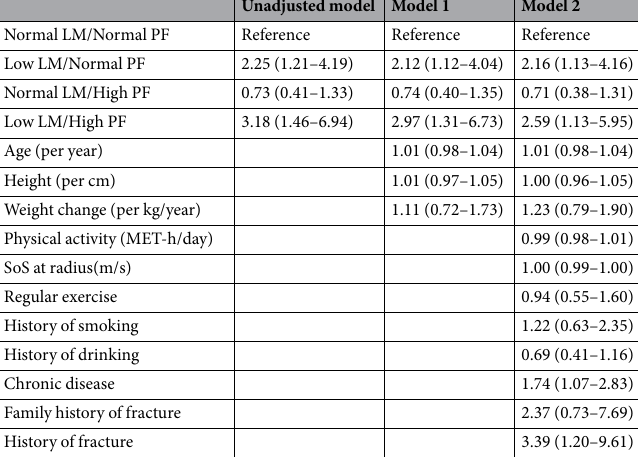
Table 4. Cox proportional hazard models for fragility fractures in men according to body composition. Data are shown as HRs (95% CI). LM, lean mass; PF, percentage body fat; Model 1, adjusted for age, height and weight change; Model 2, additionally adjusted for physical activity, speed of sound at radius, regular exercise, history of smoking, history of drinking, chronic diseases, family history of fracture, and history of fracture.